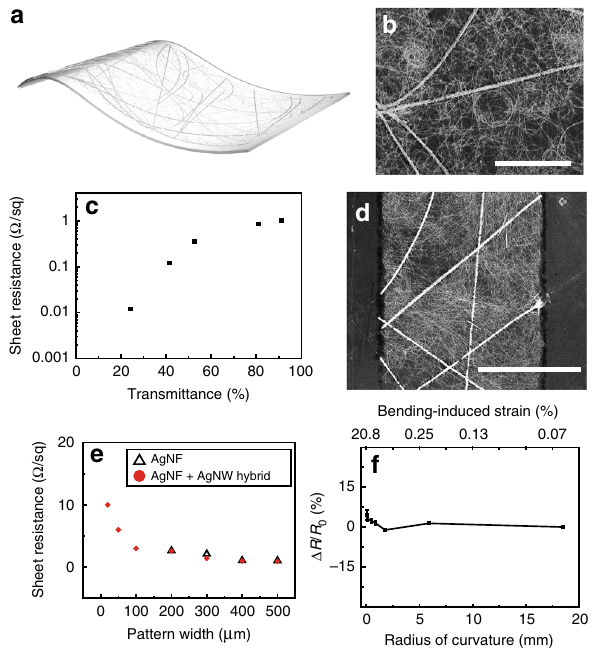
Fig. 2 Optical, electrical, and mechanical properties of the hybrid electrode. a Schematic illustration of the silver nano fi ber – silver nanowire (AgNF – AgNW) hybrid electrode. b Scanning electron microscope (SEM) of the AgNF – AgNW hybrid electrode. Scale bar, 20 μ m. c Transmittance versus sheet resistance of the AgNF – AgNW hybrid electrode. d SEM image of the patterned AgNF – AgNW hybrid electrode. Scale bar is 30 μ m. electrode (pattern length: 500 μ m). f Relative resistance changes as